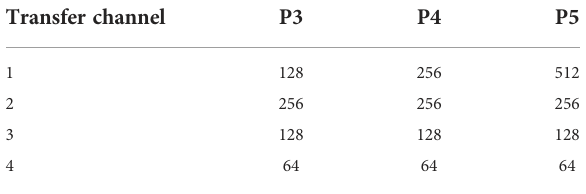
TABLE 2 The transfer channel of BiFPN.